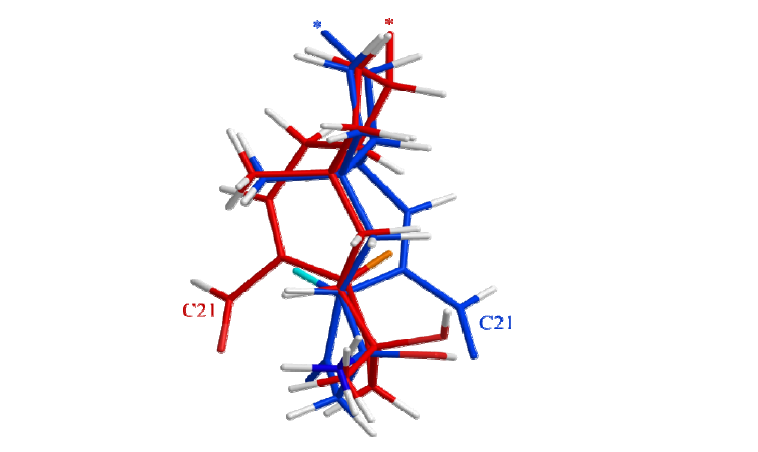
Figure 13. Modulated 3D structures of ophiobolin K (blue) and 6-epiophiobolin K (red) in their lowest energy conformations overlaid. H6 protons are marked in ophiobolin K (cyan) and 6-epi ophiobolin K (orange). The chain extending from C14 in ring C is not displayed to get a better clarity of the structures (the cut-off point is marked with